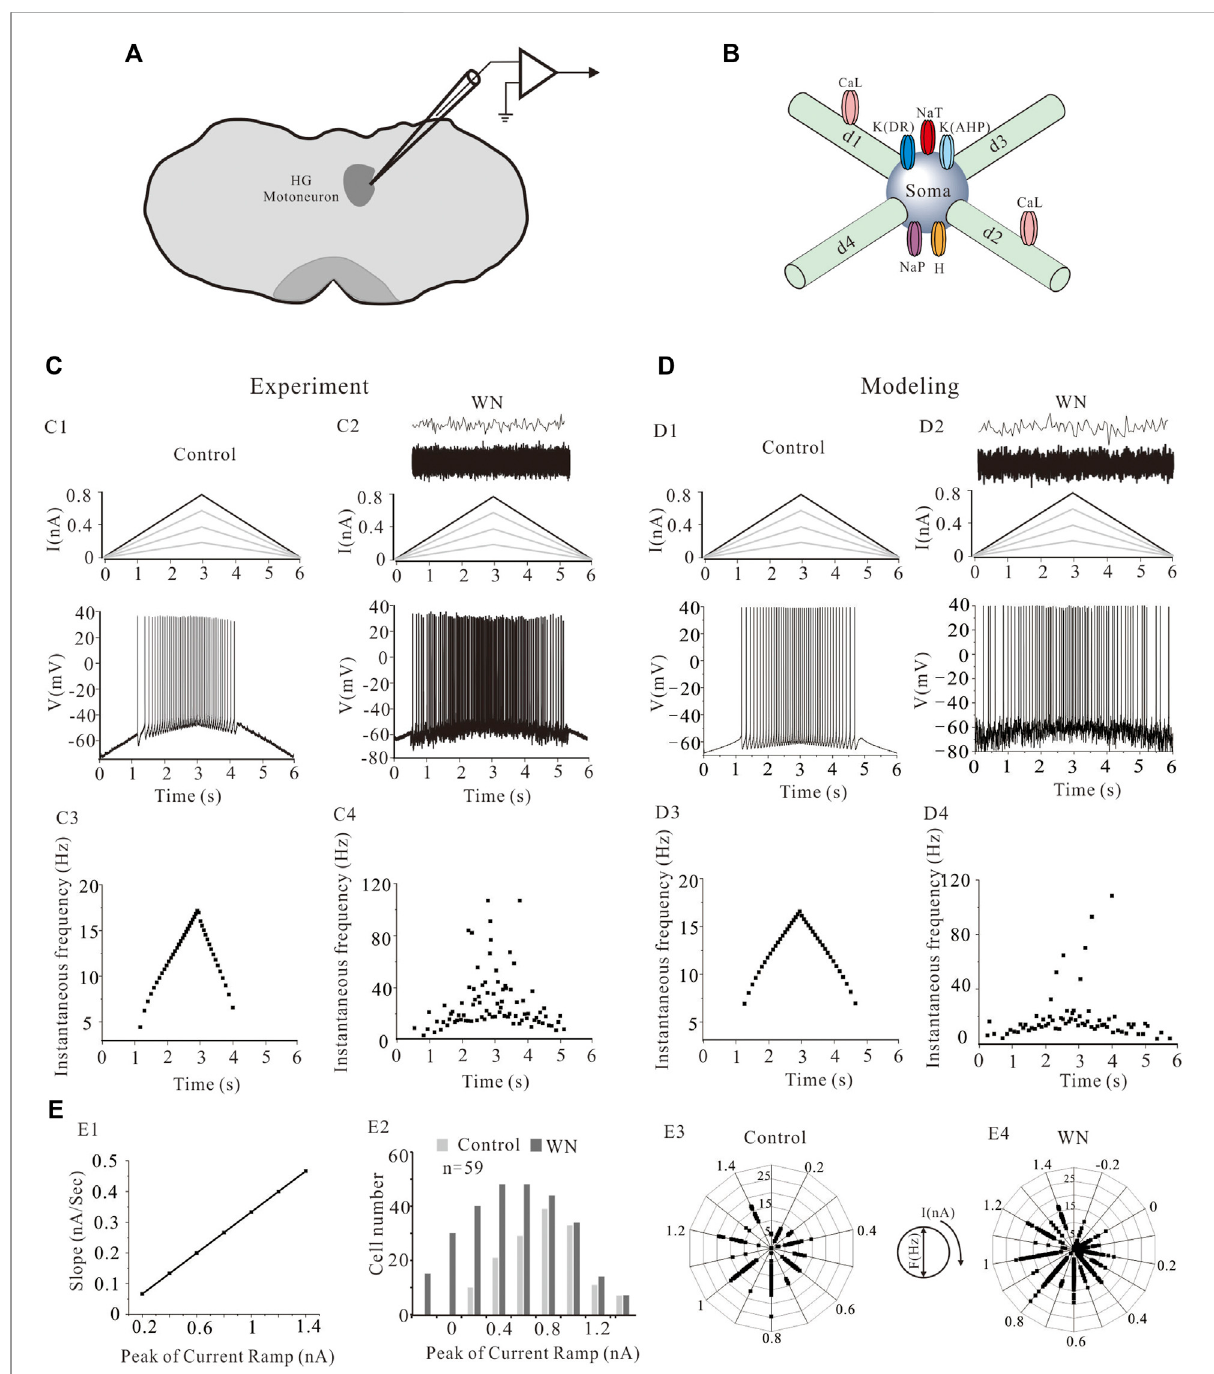
FIGURE 1 The location of hypoglossal (HG) motoneurons and a simpli fi ed HG motoneuron model. (A) The preparation of rat brainstem slices and the locationofhypoglossalnucleus. (B) FiveHGmotoneuronmodelswerebuiltandeachmodelconsistedofsomaandfourdendriticcompartments(d1, d2, d3, and d4). The soma contained transient sodium (NaT), persistent sodium (NaT), delayed-recti fi er potassium (K(DR)), Ca 2+ -dependent potassium (K(AHP)) and H-current channels. L-type calcium channels (CaL) were distributed on the d1 and d2 dendritic compartments. (C) : A family of bi-ramp currents with duration of 6 s and step of 0.2 nA ramp peak were applied to HG motoneurons and models ( C1 , top). A bi-ramp current with a duration of 6 s, peak of 0.8 nA was injected into HG motorneuron without ( C1 , top) and with white noise (WN) ( C2 , top) and repetitive fi rings were evoked without ( C1 , bottom) and with ( C2 , bottom) WN. The white noise superimposed by current transients ( C2 , top) was injected into the motoneuron. Instantaneous fi ring frequencies were calculated without (C3) and with WN (C4) from corresponding fi rings (C1,C2) , respectively. (D) : Similar recordings from simulation protocol. A bi-ramp current with a duration of 6 s, peak of 0.8 nA was injected into a HG motoneuron model